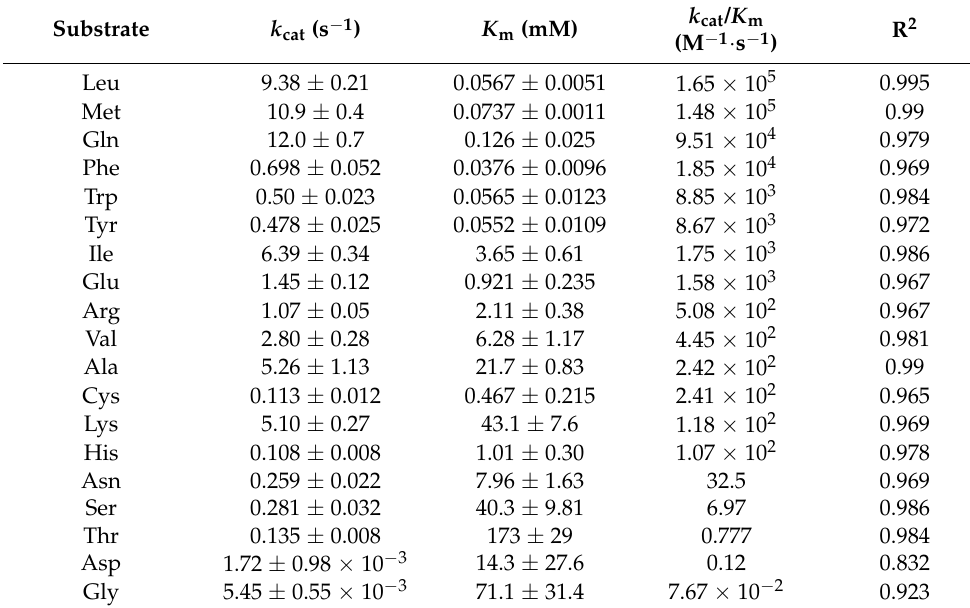
Table 1. Steady-state kinetic parameters for the reaction of P. luteoviolacea CPMOR-1 LAAO with L-amino acid substrates. Each amino acid was assayed as described in the Section 4 at pH 7, 25 ◦ C, and fit with Equation (1). Values are the average of at least three replicates. The R 2 values for the fits of the data for each amino acid substrate are